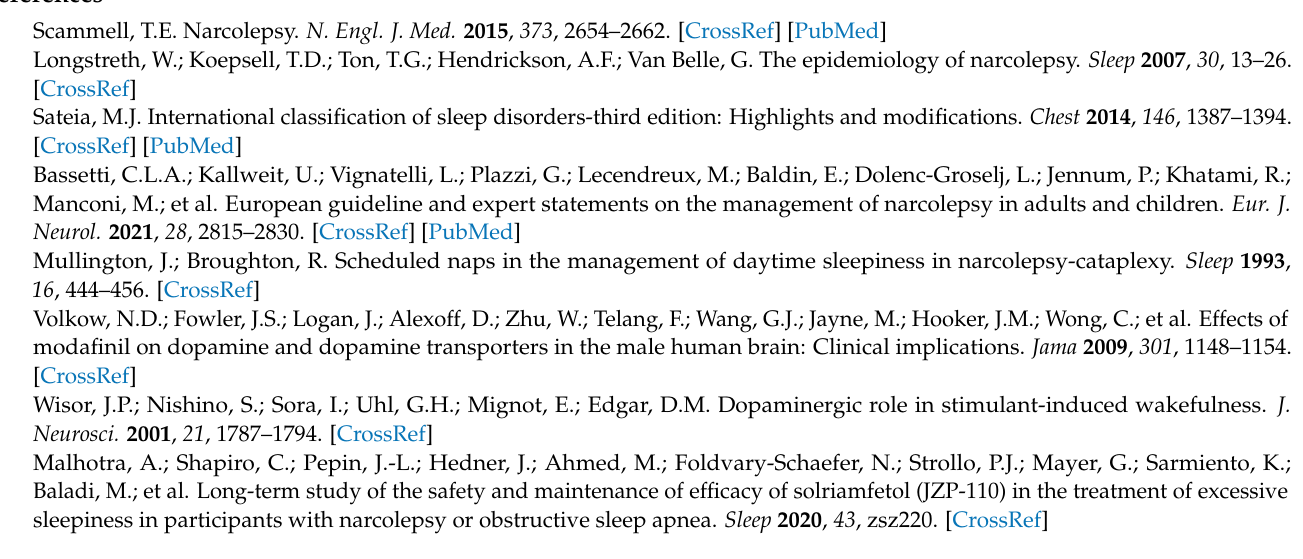
Funnel plot; Figure S20: Network graph-Trials included participants with cataplexy; Table S21: Assessment of inconsistency-Trials included participants with cataplexy; Figure S21: Forest plot- Trials included participants with cataplexy; Table S22: League table-Trials included participants with cataplexy; Figure S22: Forest plot-crossover design excluded; Table S23: League table-crossover design excluded; Figure S23: Forest plot-withdrawal design excluded; Table S24: League table-withdrawal design excluded; Table S25: Assessment of inconsistency-Cook 2002, Ahmed 2005a, and Gross 2000 excluded; Figure S24: Forest plot-Cook 2002, Ahmed 2005a, and Gross 2000 excluded; Table S26: League table-Cook 2002, Ahmed 2005a, and Gross 2000 excluded. Adverse events—Figure S25: Forest plot-gastrointestinal; Table S27: League table-gastrointestinal; Figure S26: Forest plot-immunologic; Table S28: League table-immunologic; Figure S27: Forest plot-musculoskeletal; Table S29: League table-musculoskeletal; Figure S28: Forest plot: neurological; Table S30: League table-neurological; Figure S29: Forest plot-psychological; Table S31: League table-psychological; Figure S30: Forest plot-sleep-related; Table S32: League table-sleep-related; Figure S31: Forest plot-other; Table S33: League table-other; Figure S32: Forest plot-serious; Table S34: League table-serious; Figure S33: Forest plot-trial withdrawal due to AE; Table S35: League table-trial withdrawal due to AE; Figure S34: Forest plot-any AE occurred; Table S36: League table-any AE